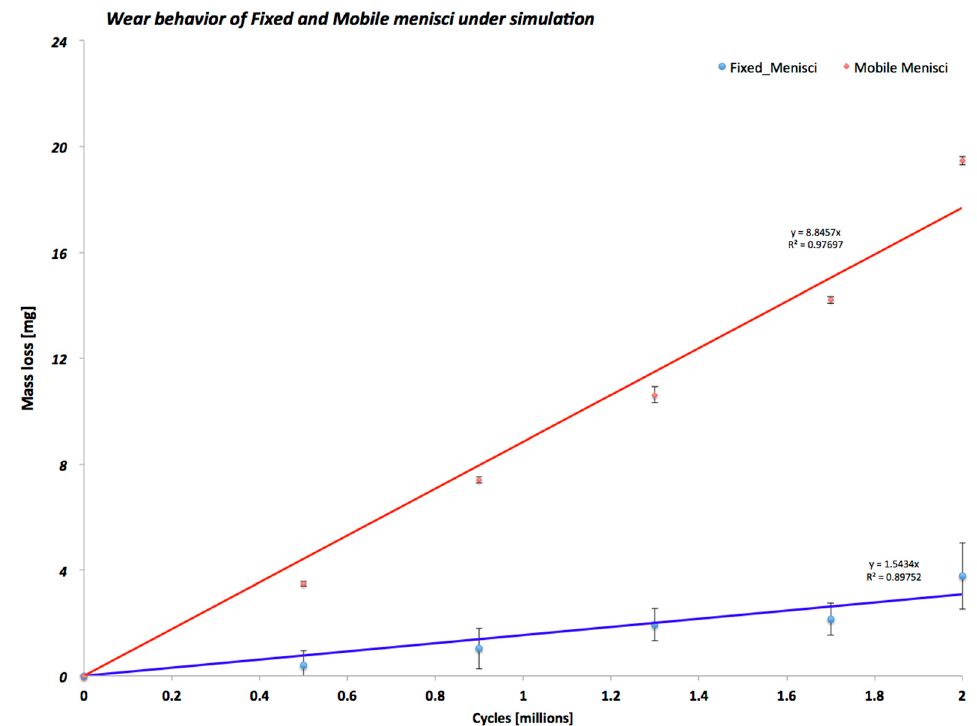
Figure 4. Wear trend and linear regression of the different fixed and mobile TKP configurations during the wear test.